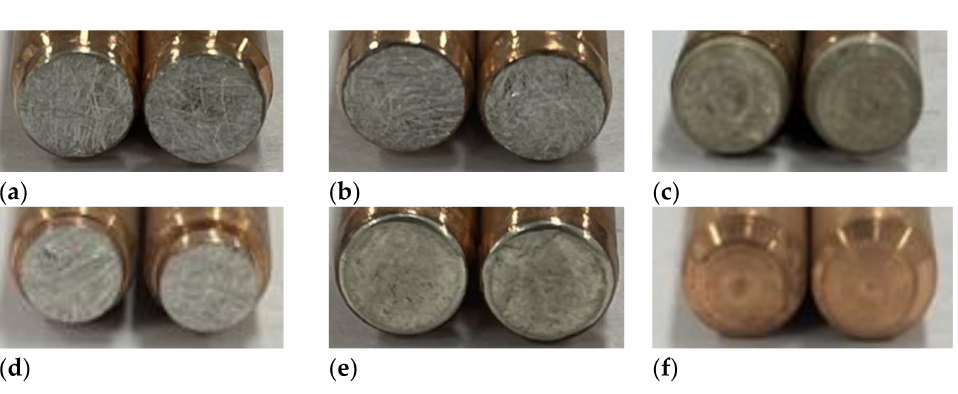
Figure 3. Photo of five kinds of samples for the electric contacts tested in this study; ( a ) AW18-Cu,